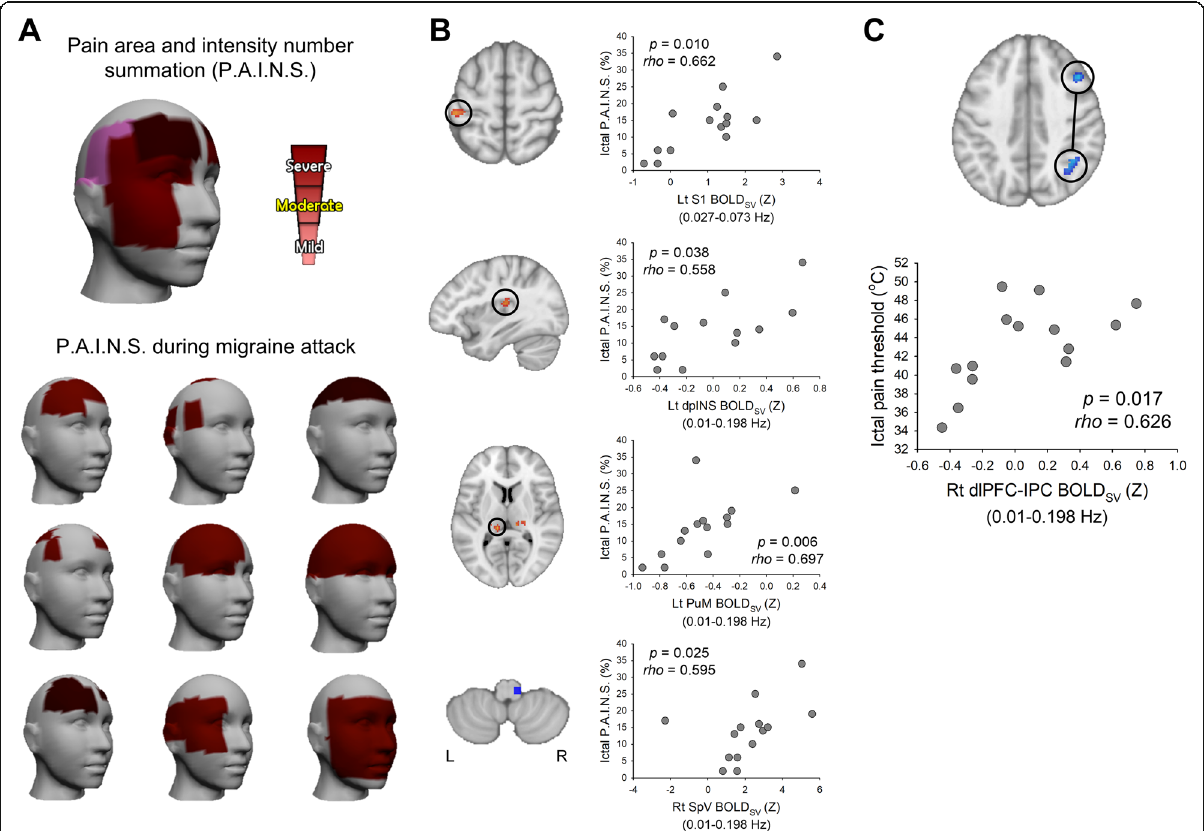
Fig. 5 Correlation between BOLD signal variability (BOLD SV ) and migraine headache severity. a Migraine headache severity was assessed by using mobile application PainTrek (currently named GeoPain) (MoxyTech Inc., MI) during migraine attacks. Pain area (220 cells) and intensity number (mild pain-1, light red; moderate pain-2, red; severe pain-3, dark red) summation cumulative score (0 – 660) was converted to a percentage. Example 3D head image shows individually recorded P.A.I.N.S. from migraine patients during headache attacks. b The black circles in the brain image indicate the locations of the maximal difference (control < migraine) in BOLD SV within the frequency of 0.01 – 0.198 Hz except for S1, which was significant in the slow-4 (0.027 – 0.073 Hz) band. Mean BOLD SV (Z) was extracted from a 3-mm sphere around the peak voxel of each cluster. c The thermal pain threshold during migraine attacks was measured on the ophthalmic trigeminal region. The black circles in the brain image indicate the locations of the maximal difference (control > migraine) in BOLD signal variability within the frequency of 0.01 – 0.198 Hz. Extracted mean BOLD SV (Z) of the right dlPFC and IPC was